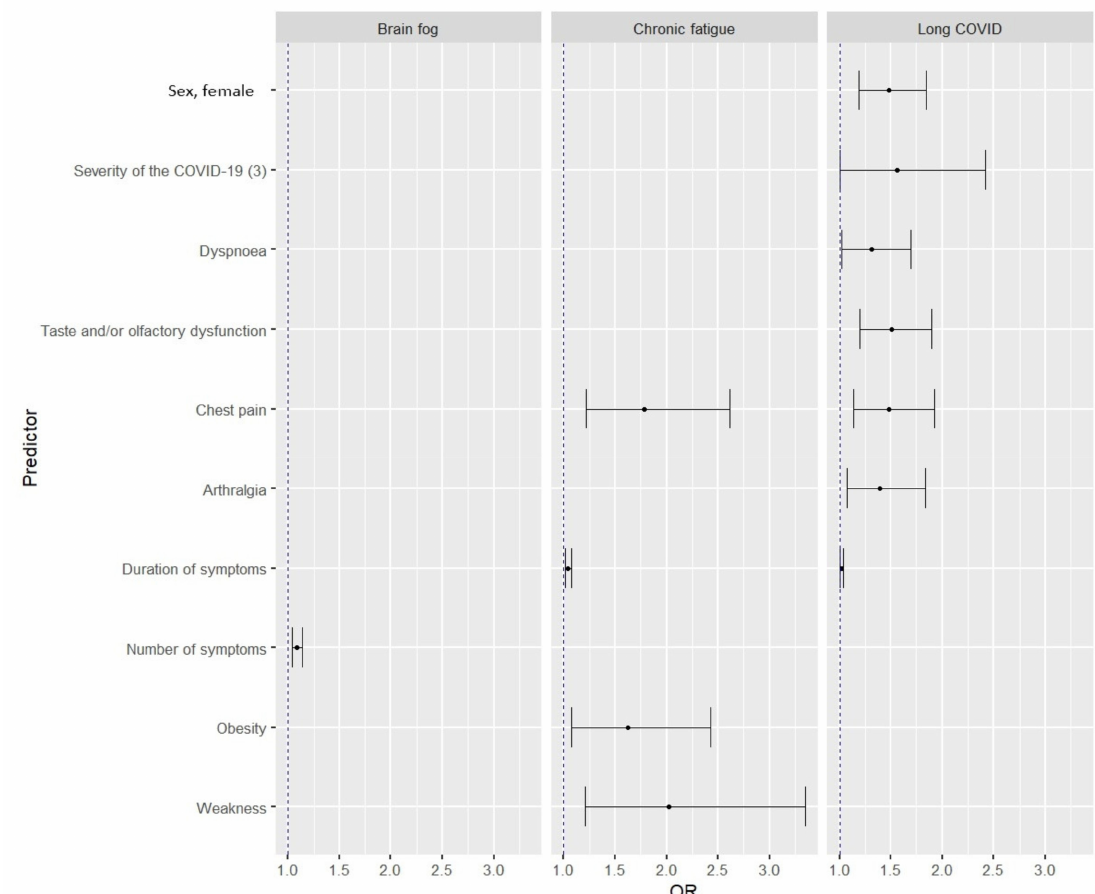
Figure 2. Predictors of the risk of developing long-COVID, brain fog, and chronic fatigue in multi- variate